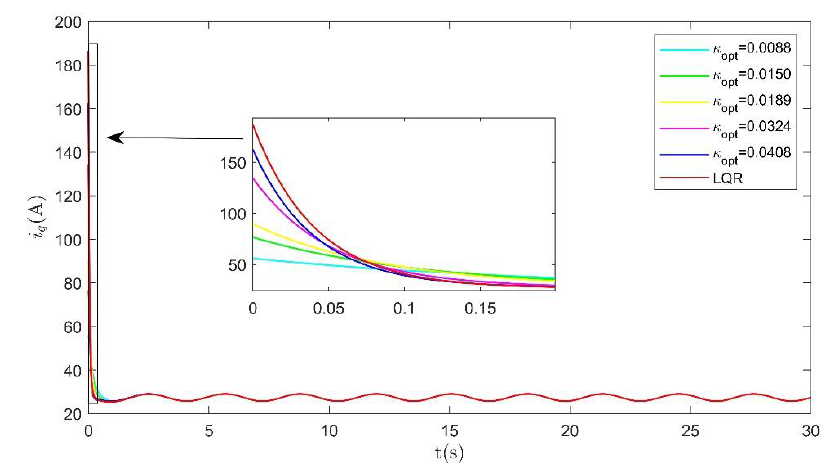
Figure 9. The sinusoidal tracking control cost curve of the electric tail reduction system.